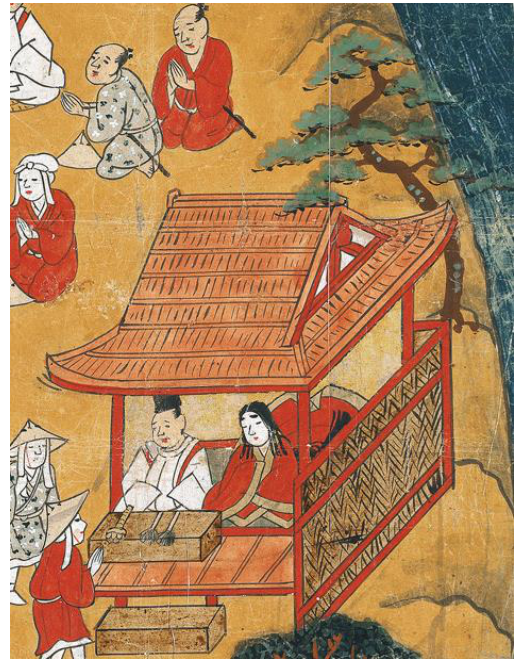
Figure 12. Ise Pilgrimage Mandala, late 16th century, hanging scroll, ink and colors on paper, 67 ½ × 73 ¼ in. (171.4 × 186 cm). Jingū Chōkokan Museum, Mie Prefecture, Japan. Detail of Naikū Kora no tachi.